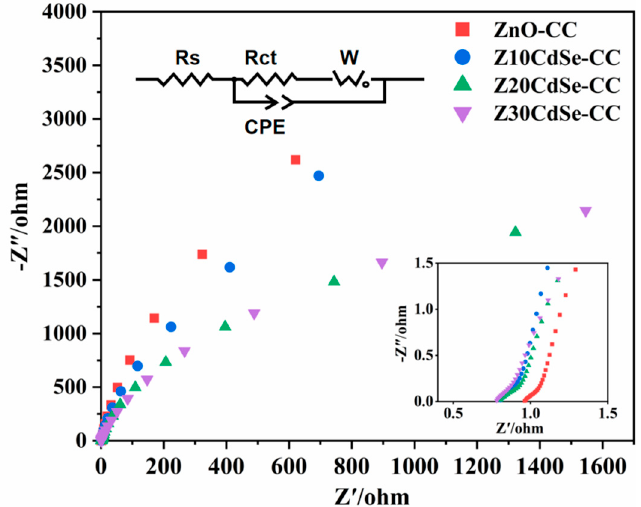
Figure 8. EIS Nyquist plot of ZnO − CC, Z10CdSe − CC, Z20CdSe − CC, and Z30CdSe − CC3.5. Photo- catalytic Studies.